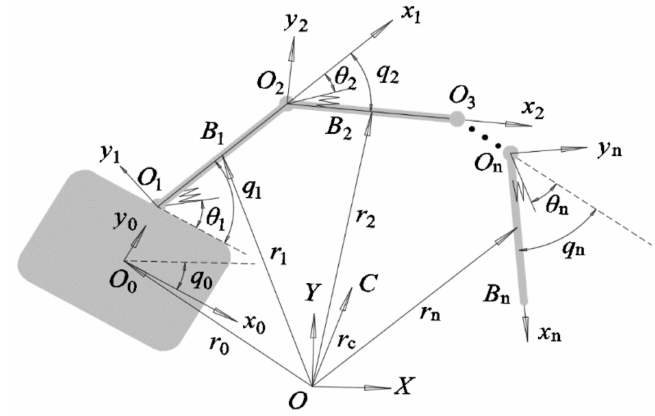
Figure 2. The free-floating flexible-joints space